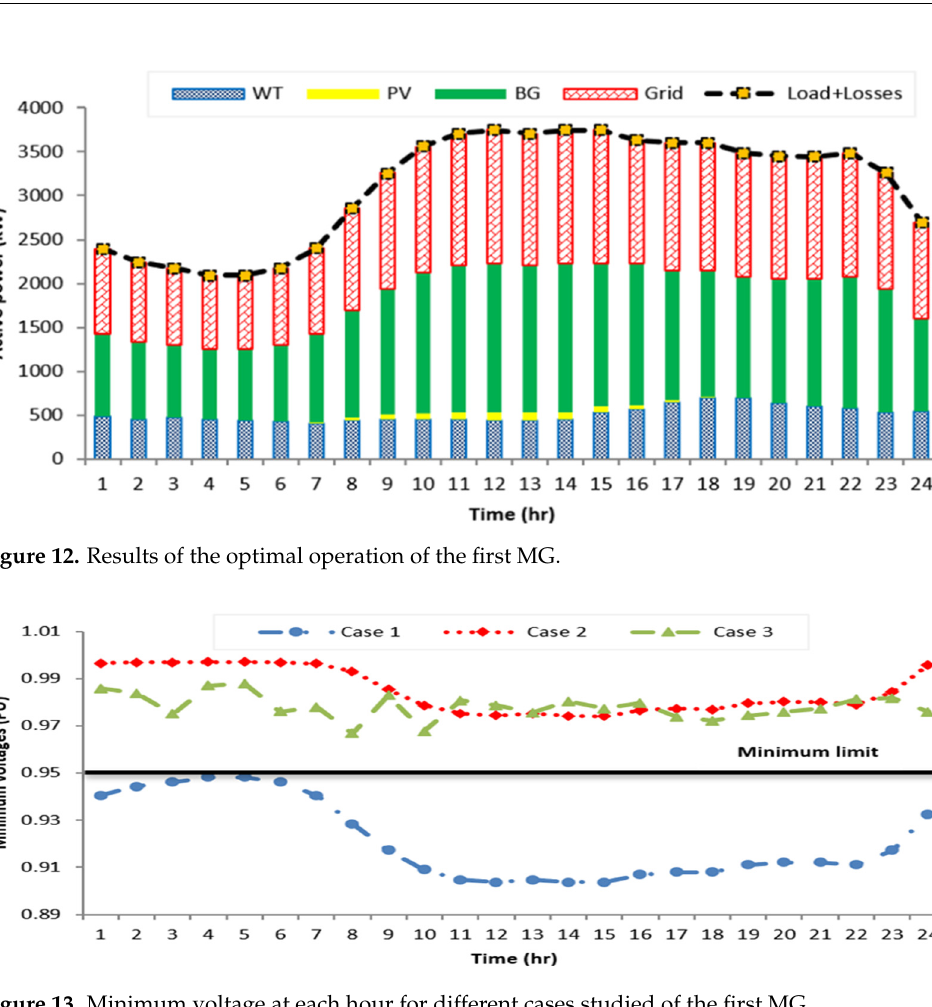
Figure 13. Minimum voltage at each hour for different cases studied of the first MG.